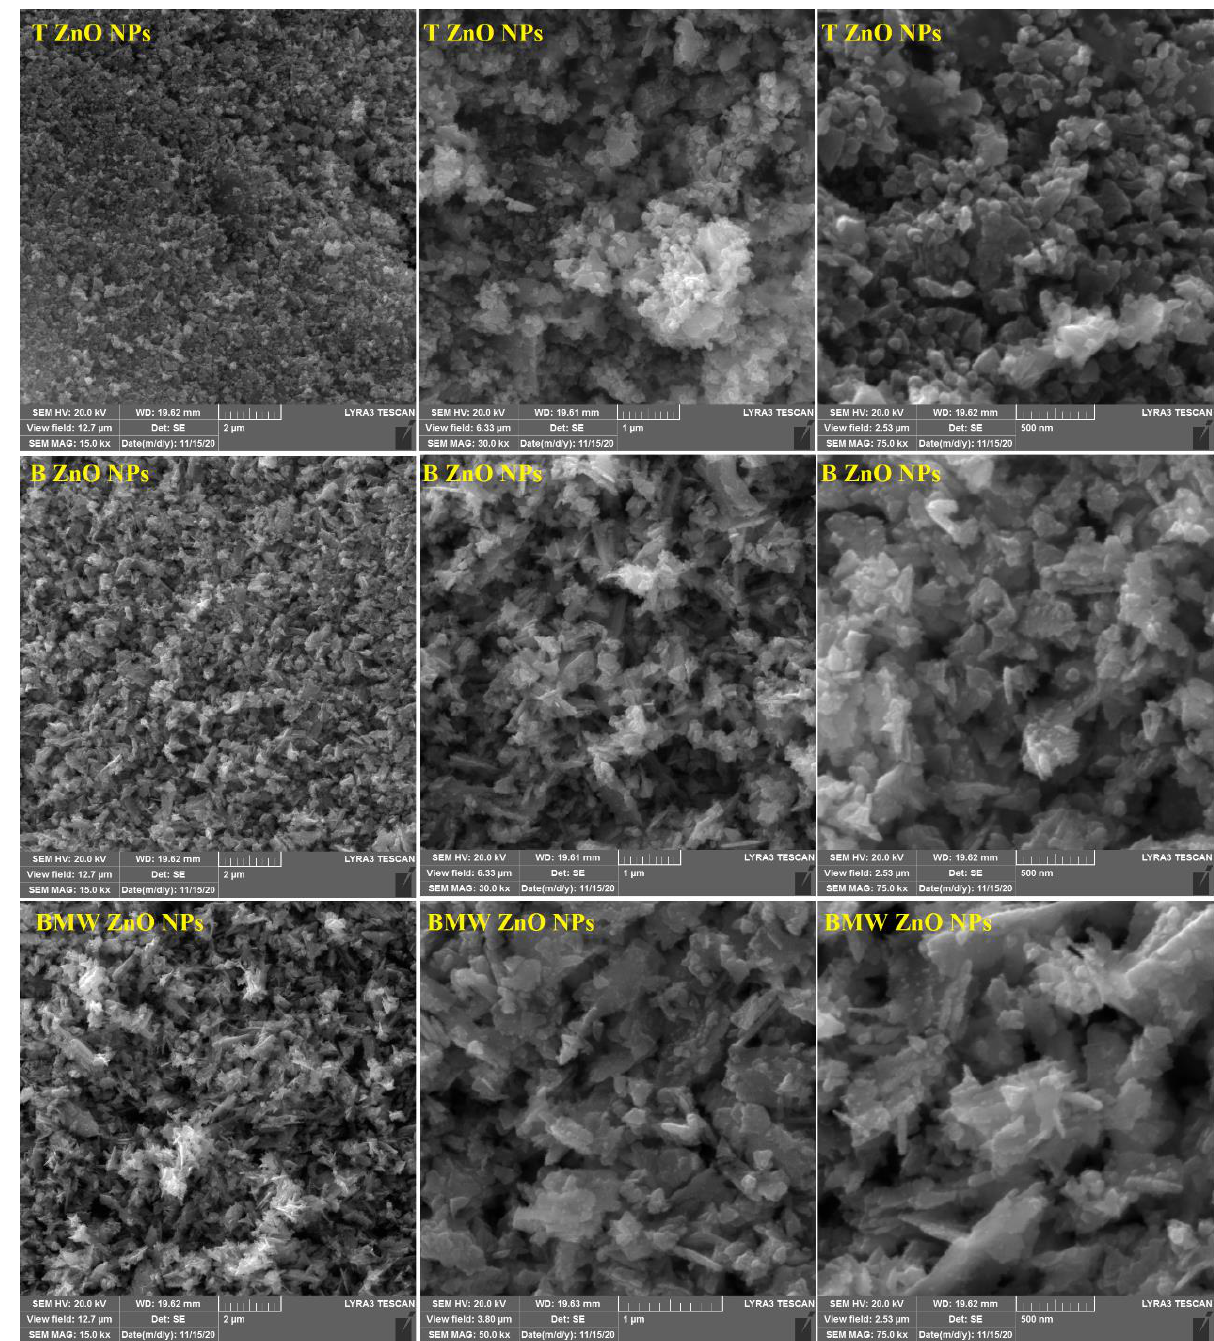
Figure 3. SEM micrographs of different ZnO NPs.